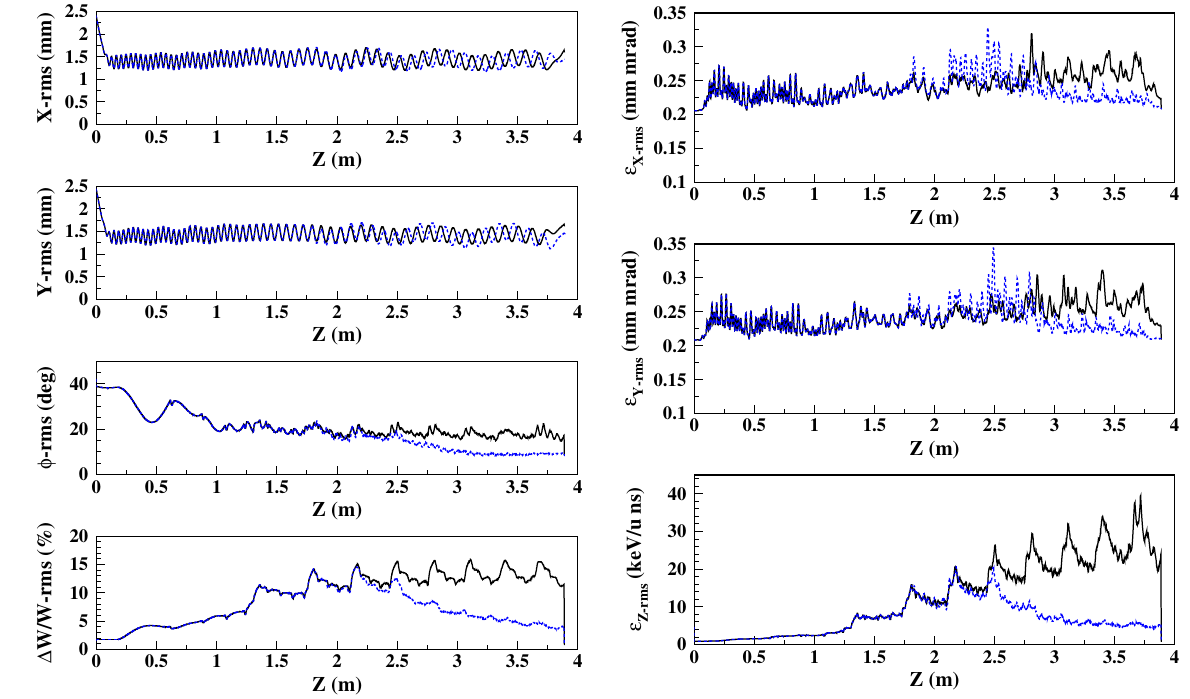
FIG. 11. Comparison between the original sinusoidal design (solid black) and the final trapezoidal design (dashed blue). On the left are rms beam envelopes and on the right are rms emittances along the RFQ. The curves include all particles within the aperture (accelerated or not). The peaks and valleys on the longitudinal plots, corresponding to oscillations of nonaccelerated particles, continue to develop in the sinusoidal design but they stop in the trapezoidal design due to filtering of the longitudinal tail discussed in the text.